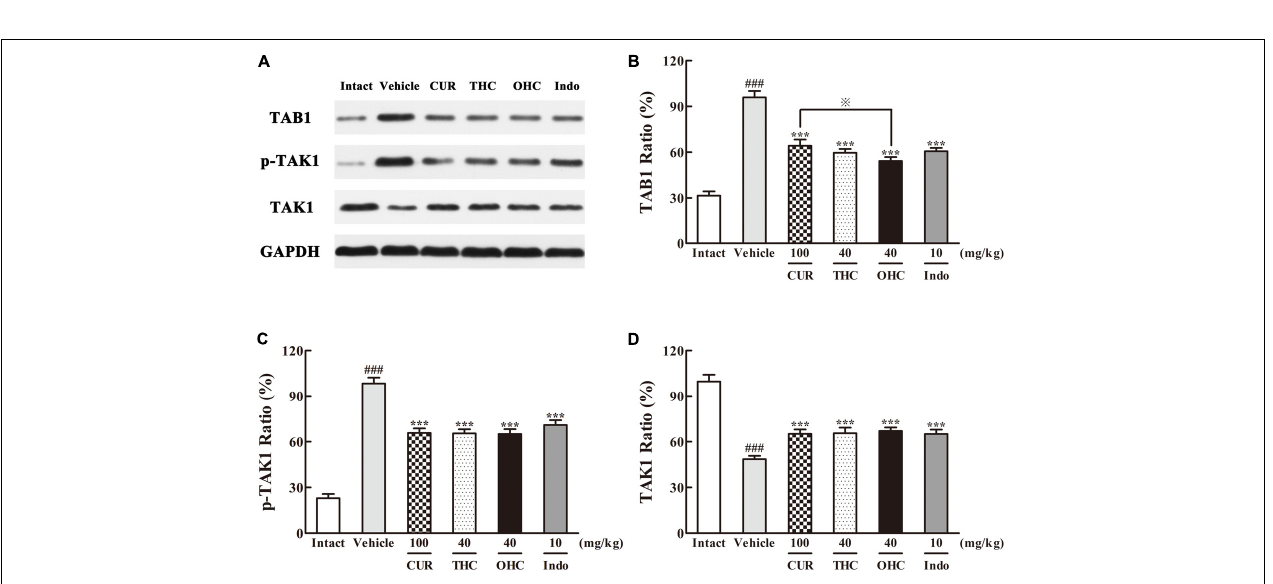
FIGURE 6 | Effects of (A) Representative lanes of TAB1, p-TAK1, and TAK1. THC and OHC on TAB1 (B) , p-TAK1 (C) , and TAK1 (D) protein expressions in the carrageenan-induced mouse paw edema. After administration with THC (40 mg/kg, i.g.), OHC (40 mg/kg, i.g.) or CUR (100 mg/kg, i.g.) for 7 days, the hind paws were removed and homogenized in the lysis buffer, and then the protein extracts of hind paws were transferred to polyvinyl difluoride (PVDF) membranes and analyzed by Western blot. GAPDH was employed as loading control. Data were expressed as means ± S.E.M. ( n = 3), ### p < 0.001 vs. the intact control; ∗∗∗ p < 0.001 vs. the vehicle control; ※ p < 0.001 vs. the CUR group. Significant differences between groups were determined by ANOVA and Dunnett’s post hoc test.